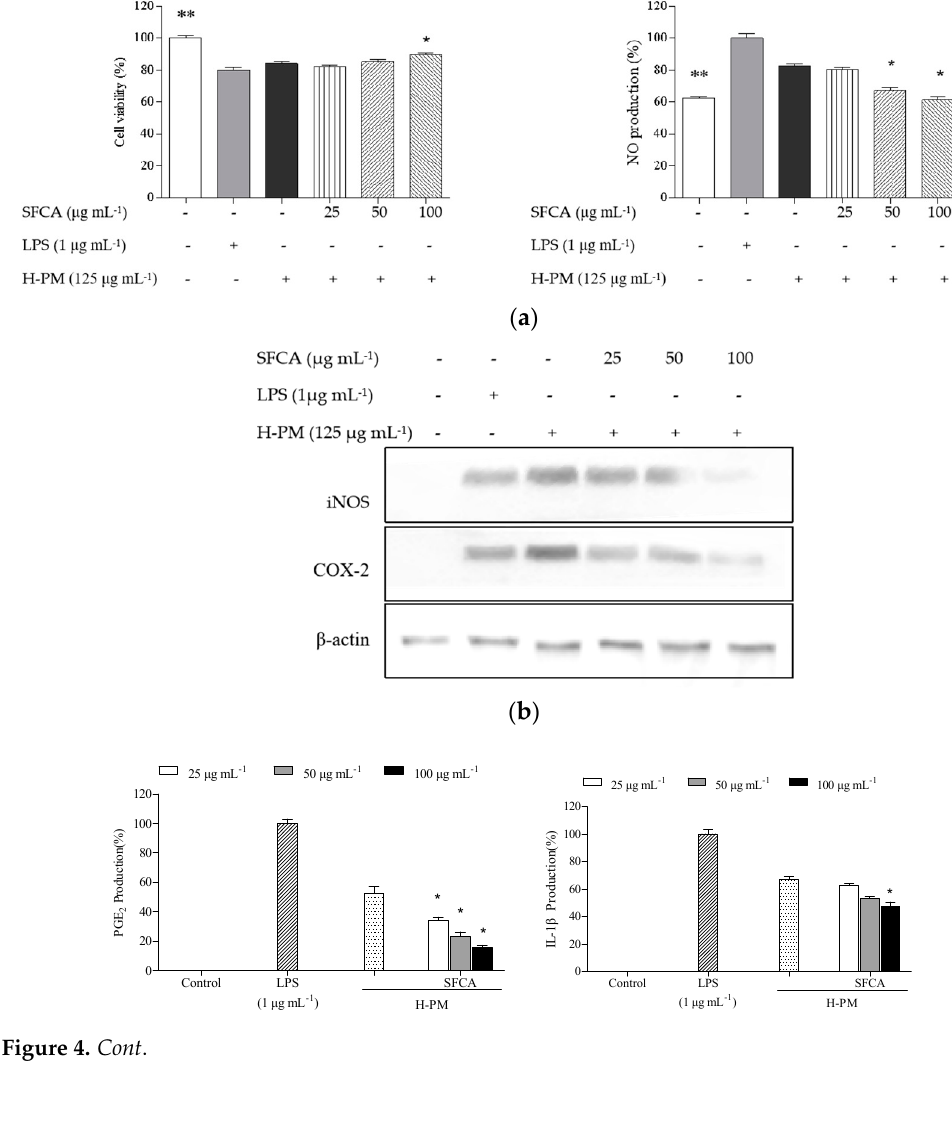
Figure 4. Inflammatory stimulation of the RAW 264.7 macrophages by the culture medium of PM- induced HaCaT cells and the anti-inflammatory effects of SFCA: NO production and cytotoxicity ( a ) and analysis of iNOS and COX-2 levels ( b ) and inflammatory mediators ( c ), including tumor necrosis factor α (TNF- α ), interleukin (IL)-1 β , IL-6, and PGE 2 . HaCaT cells were pre-seeded in culT- able 1. × 10 5 cells mL − 1 ), incubated for 24 h, and treated with or without different concentrations of SFCA. After 1 h, the cells were treated with PM (125 μ g mL − 1 ) and 24 h later, culture media were treated to each pre-seeded RAW 264.7 macrophage culture well plates in real time. The evaluations were conducted after a 24 h. Experiments were carried out in triplicate, and the results are repre- sented as means ± SE. Values are significantly different from the positive control (PM treated group) at * p < 0.05 and ** p < 0.001. H-PM: cultured medium of PM-stimulated in keratinocytes.